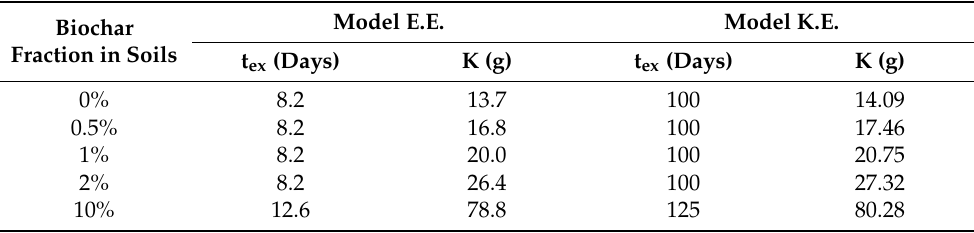
Table 5. Total mass of K eluted from the columns (M el , g) according to E.E. and K.E. models until exhaustion time (t ex ,